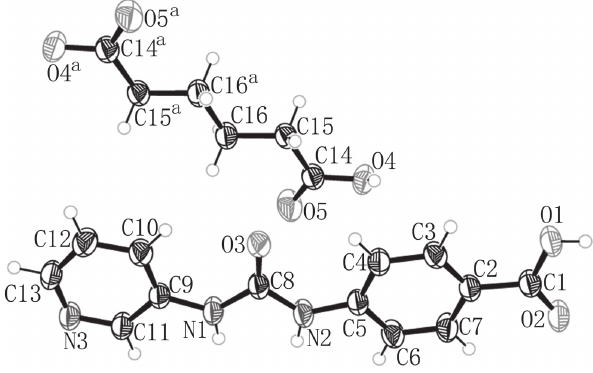
Table 1: Data collection and handling.